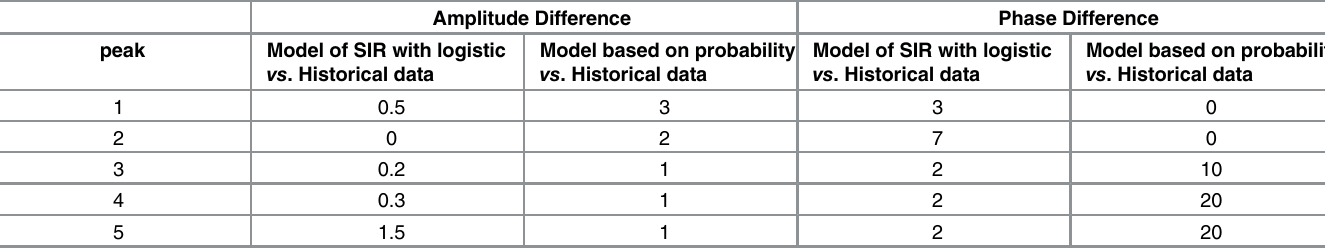
Table 1. Amplitude and phase difference of two models compared with historical data. peak Model of SIR with logistic Model based on probability Model of SIR with logistic Model based on probability vs . Historical data vs . Historical data vs . Historical data vs . Historical